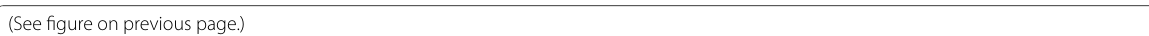
Additional file 1: Table S1. Ingredient and chemical composition of the experimental